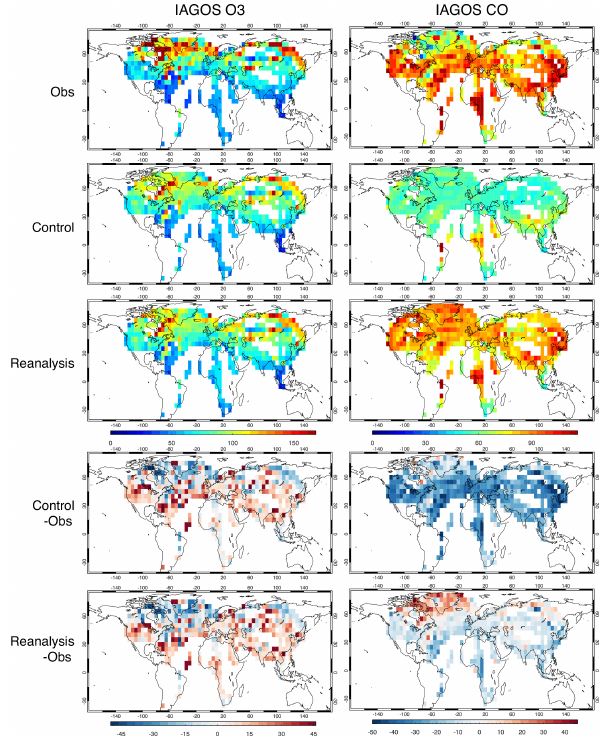
Figure 7. Spatial distributions of O 3 (left column) and CO (right column) averaged between 500 and 300hPa and during 2005–2012 obtained from the MOZAIC/IAGOS aircraft measurements (first row), control run (second row), and reanalysis (third row). Differ- ences between the control run and observations (fourth row) and between the reanalysis and observations (fifth row) are also plotted. Units are